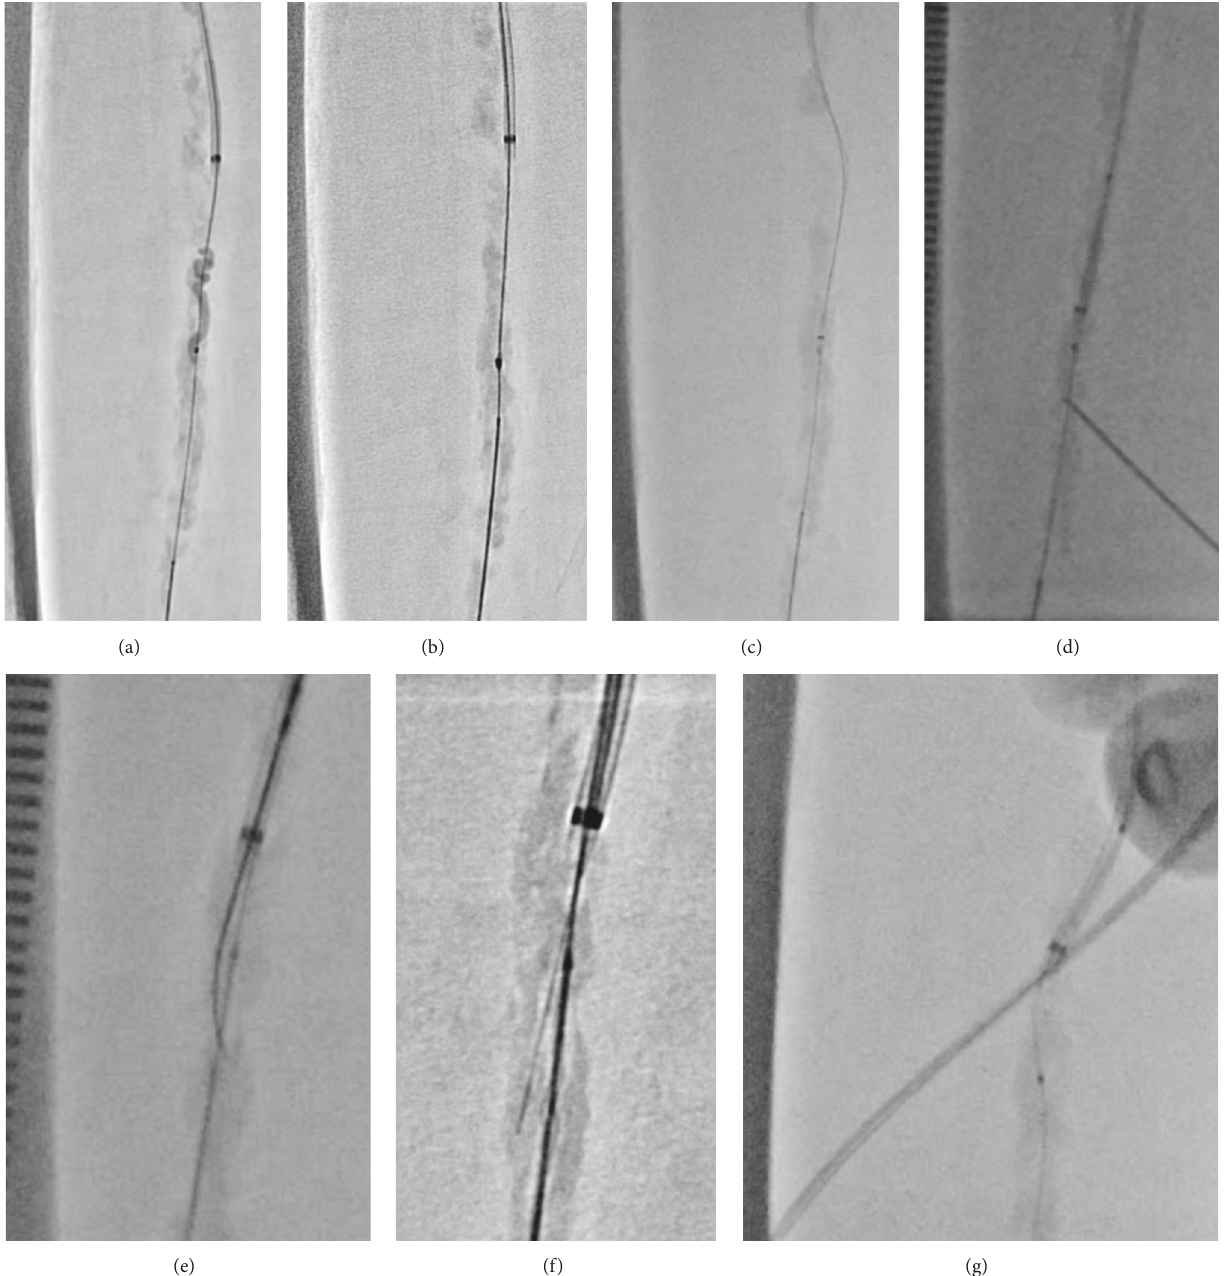
Figure 3: Devices thatfailed to cross the lesion. (a) The thin balloon is bent.(b) The Corsair PV microcatheteris fractured.(c) Crosser system cannot pass the lesion. (d) The needle cracking technique from outside of the vessel. (e) Needle cracking technique from inside of the vessel using the stiff wire. (f) Needle cracking technique from inside of the vessel using the tail of the wire. (g) The thin balloon cannot pass the lesion even after these devices and